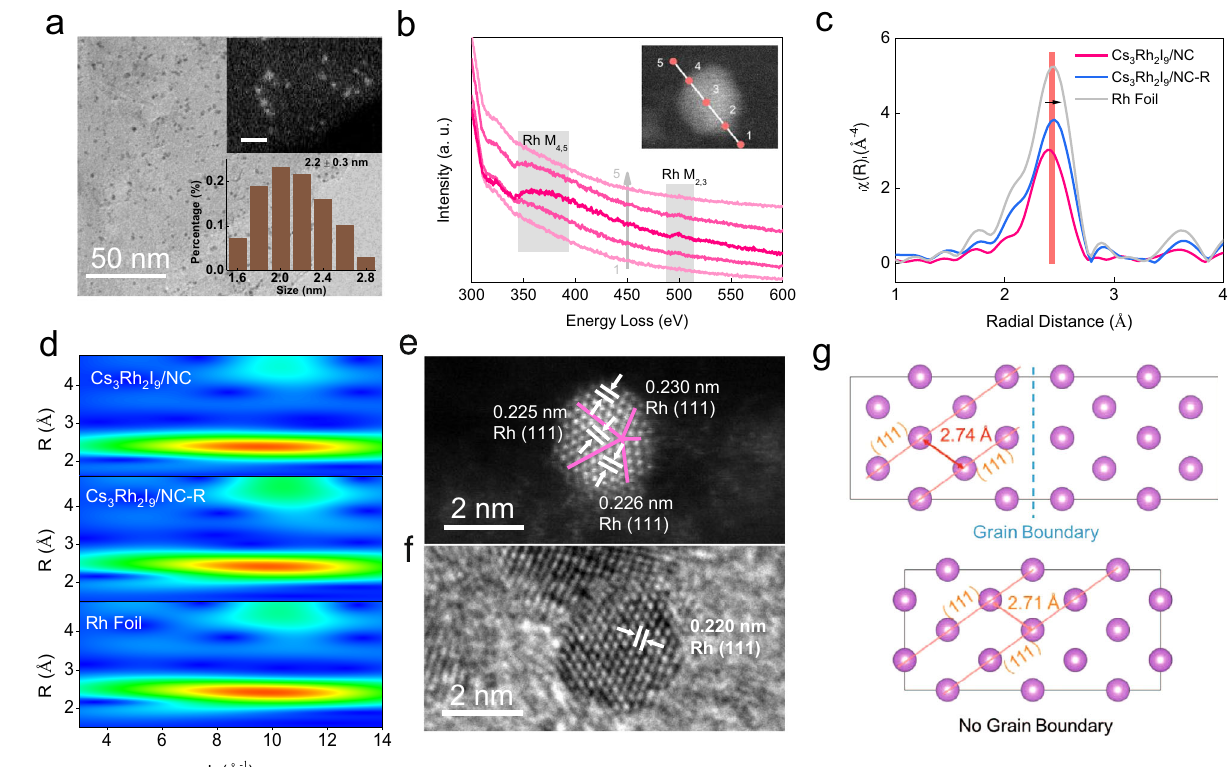
Fig. 4 | Characterization of Cs 3 Rh 2 I 9 /NC-R prepared by electrochemical reduction of Cs 3 Rh 2 I 9 /NC. a TEM image of Cs 3 Rh 2 I 9 /NC-R, showing uniform dis- persion of Rh nanoparticles. The inset shows the corresponding HAADF image (scale bar: 5nm, up) and particle size distribution (down). b The linear electron energy loss spectroscopy of Cs 3 Rh 2 I 9 /NC-R. c Fourier transform EXAFS of the Rh K-edge inR-space for Cs 3 Rh 2 I 9 /NC, Cs 3 Rh 2 I 9 /NC-R and Rh foil. d WT-EXAFS images